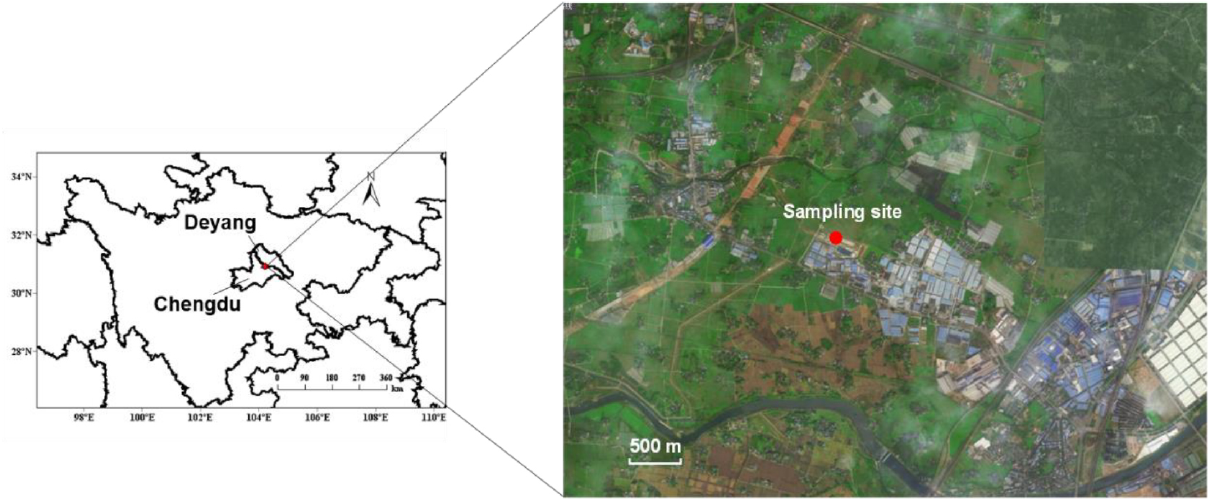
Figure 1. Location of the observation site (from Baidu Maps, © Baidu – GS(2021)6026, 2022).